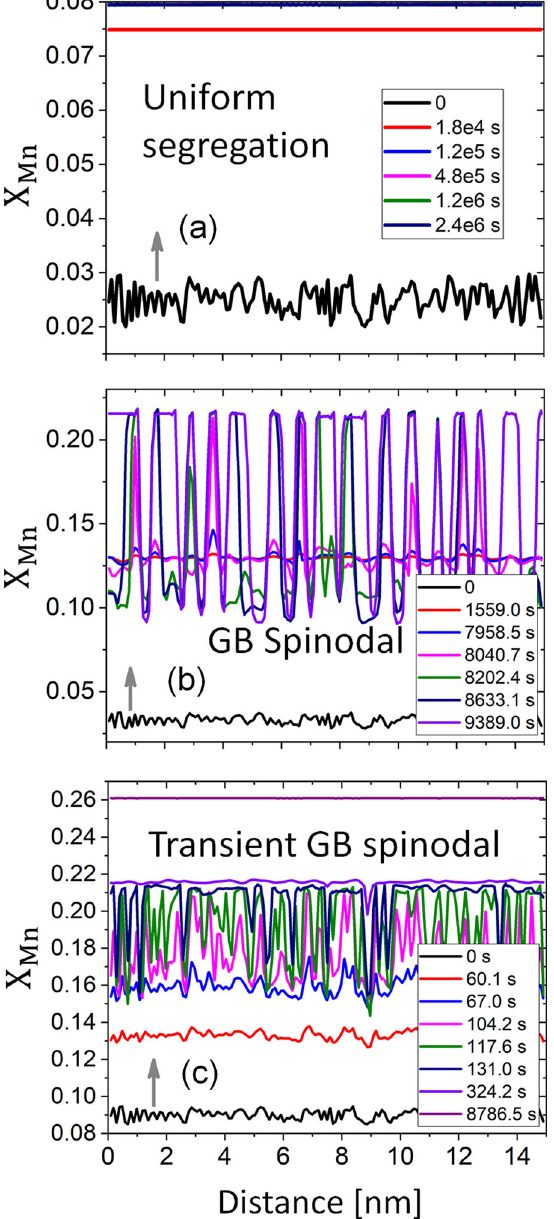
Fig. 6 Simulated time evolution of the Mn concentration in the GB plane. a 2.9, b 3.3, and c 9 at.% Mn alloy compositions were studied. For an 2.9 at.% Mn alloy (below the jump composition), segregation increases monotonically and it is stable even after long simulation times. For a composition very close to the jump composition (3.3 at.% Mn), a spinodal GB phase separation is observed. Above the jump composition (9 at.% Mn) a transient spinodal regime is observed before reaching the equilibrium Mn segregation level.